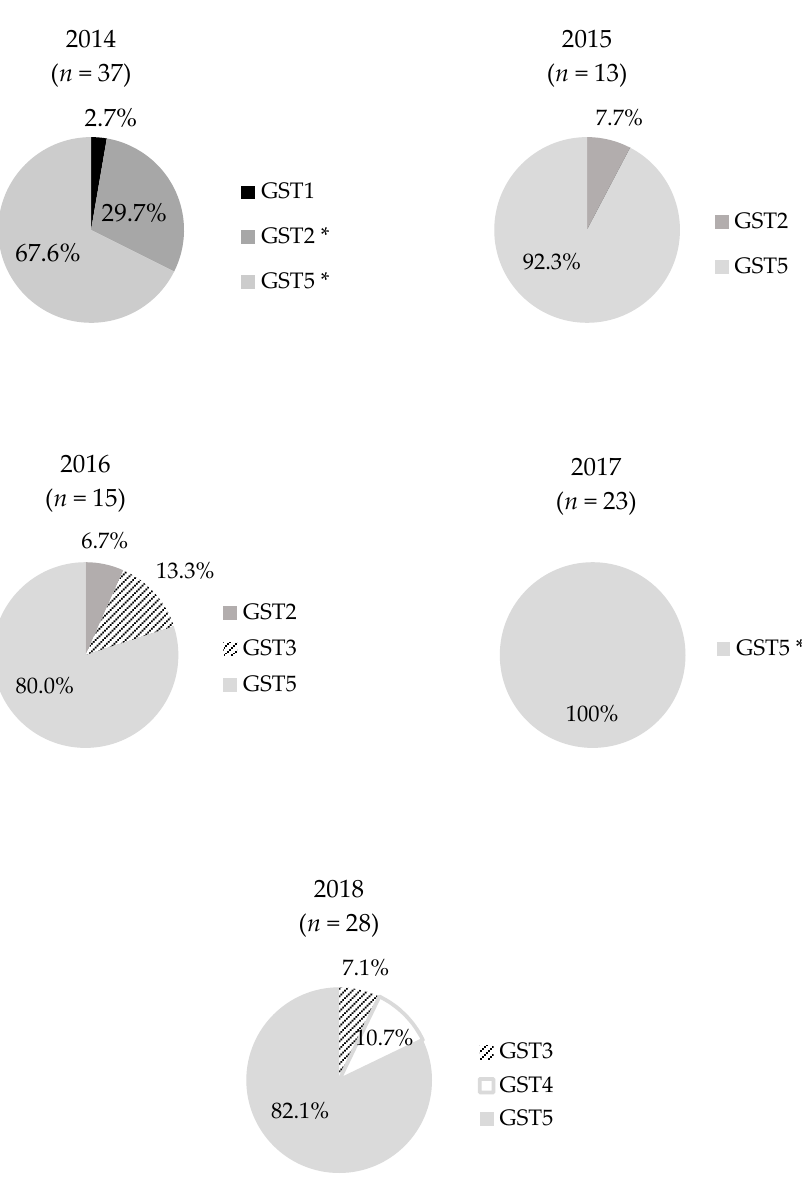
Figure 2. Pie charts of GSTs of 116 Salmonella Gallinarum isolates. Distribution of GSTs and their ratio of each year is presented on pie chart. Each color shows different GSTs as in the legend on the right side. * p < 0.05.